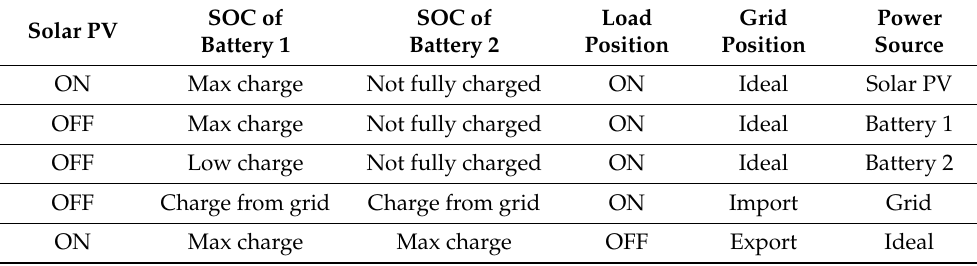
Table 1. Parameter-based logical operation for the proposed